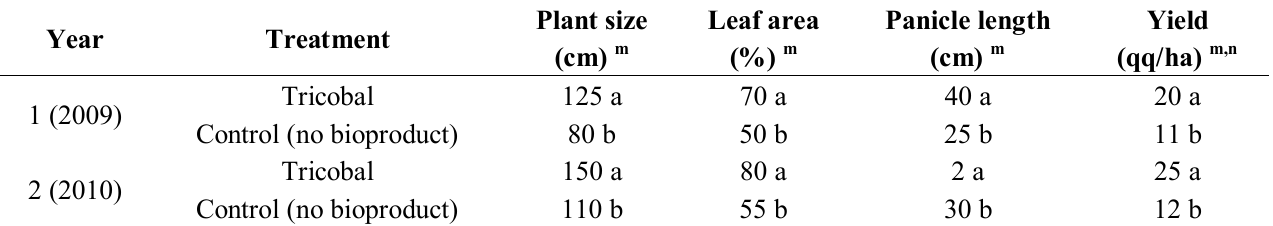
Table 2. Bioproduct amendment effect on the development and yield of